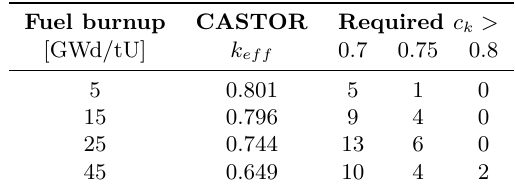
Table 2. Amounts of reactor criticals with c ilarity higher than 0.7, 0.75 and 0.8 to storage cask CASTOR systems in various levels of